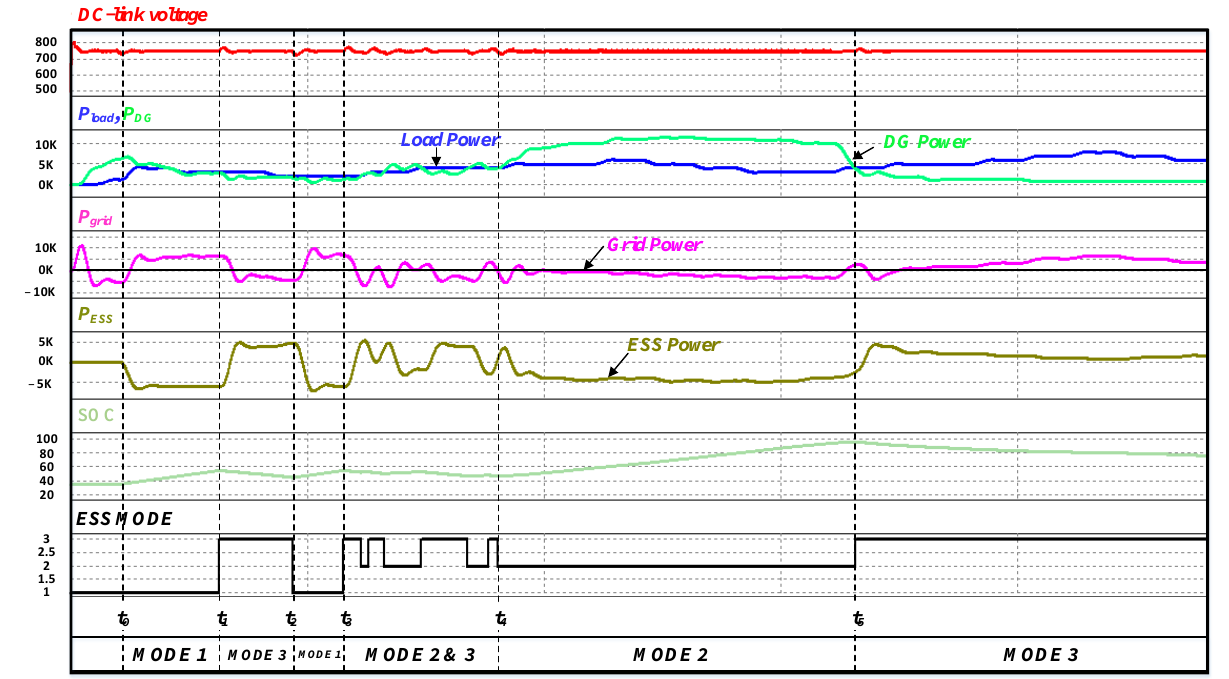
Figure 15. Simulation result of EMS when applying ANN theory.